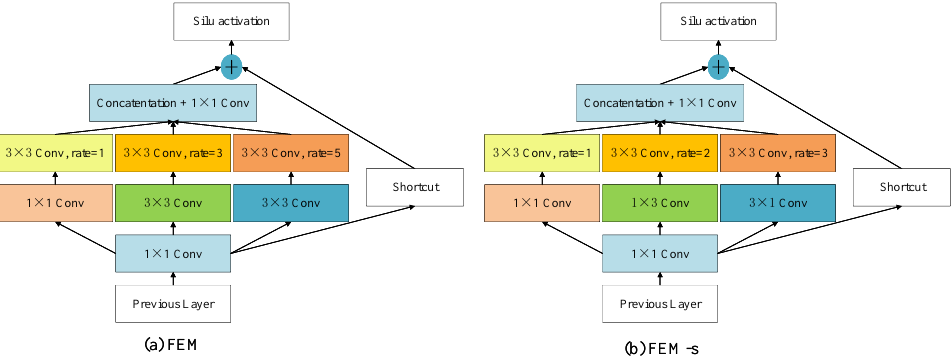
Figure 5. The structure of FEM and FEM-s. FEM is employed in the large-resolution feature map, and FEM-s is employed in the small-resolution feature